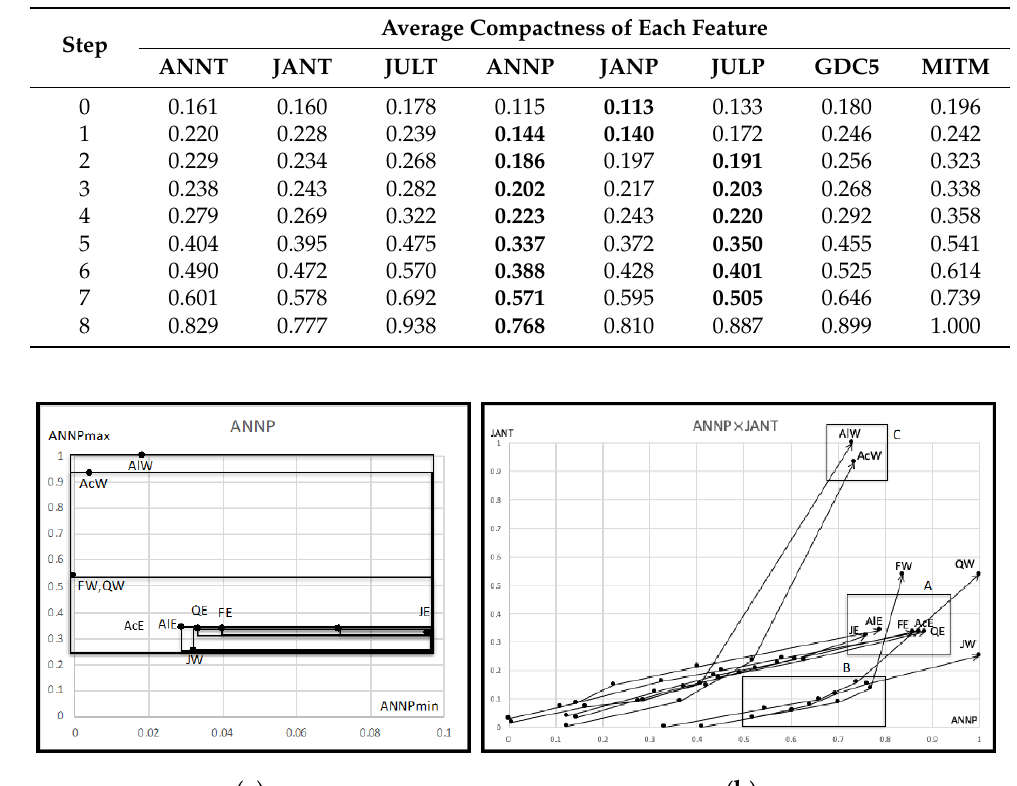
Table 10. Average compactness of each feature in each clustering step.